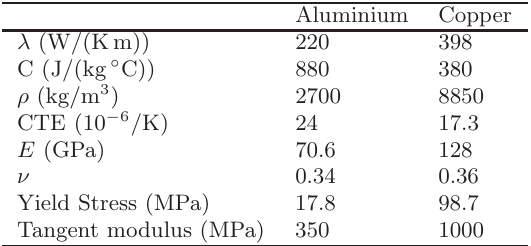
Table 2. Metallization constitutive laws parameters [4].